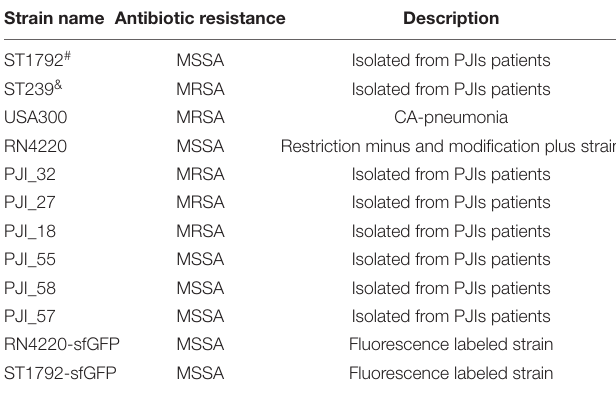
TABLE 1 | Strains used in this